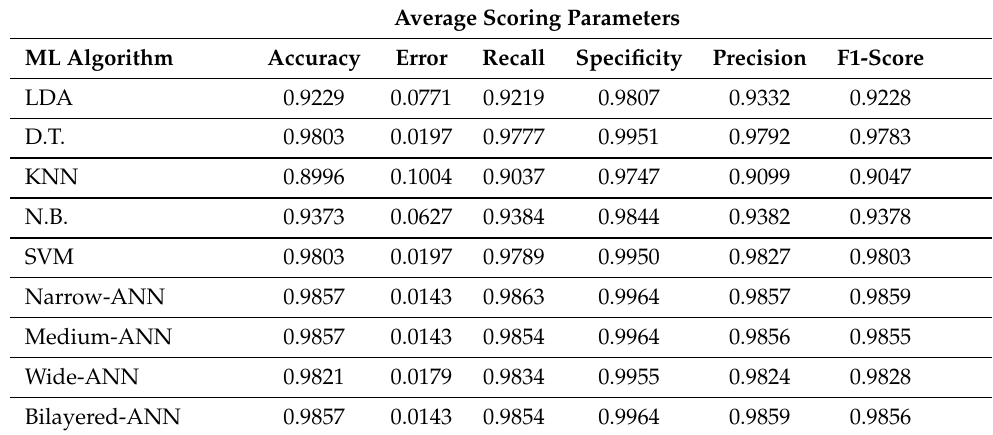
Table 4. The average score parameters of the EEG classification algorithms.